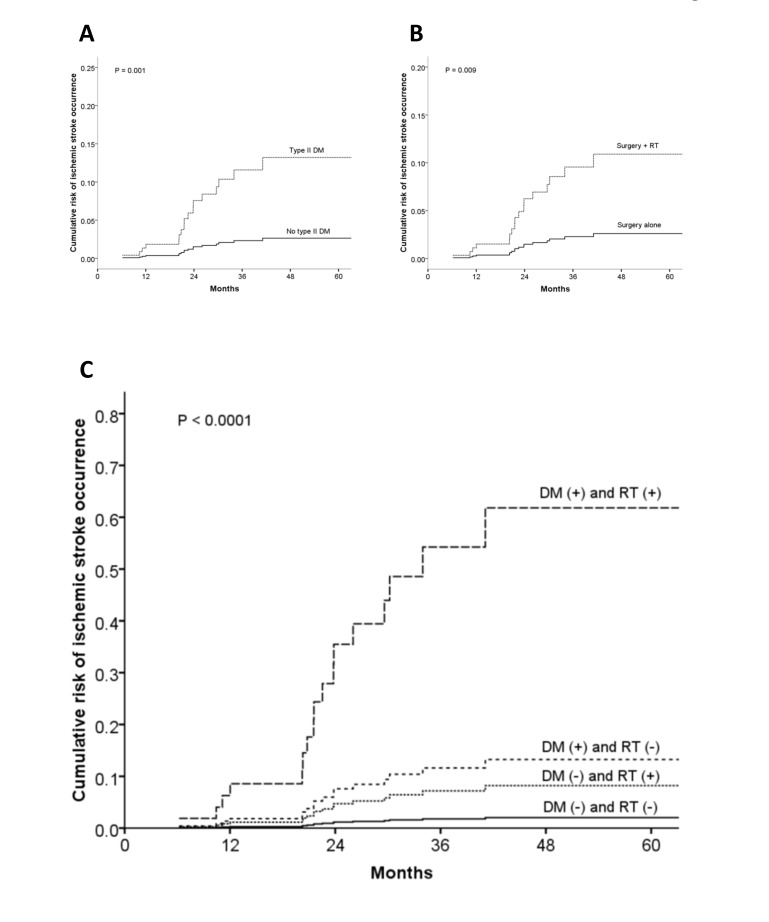
Cumulative risk estimates of ischemic stroke occurrence according to diabetes and irradiation.
Panel 3A, adjusted HR in patients with type II diabetic mellitus (DM), 5.02 (95% CI 1.86–13.53; P = 0.001), when compared with those without type II DM; Panel 3B, adjusted HR in the surgery + RT group, 4.19 (95% CI 1.44–12.22; P = 0.009), when compared with the surgery alone group; and Panel 3C, the highest HR in patients with both DM and RT, 34.74 (95% CI 6.35–>100; P<0.0001), when compared with patients with both of none (reference value = 1).